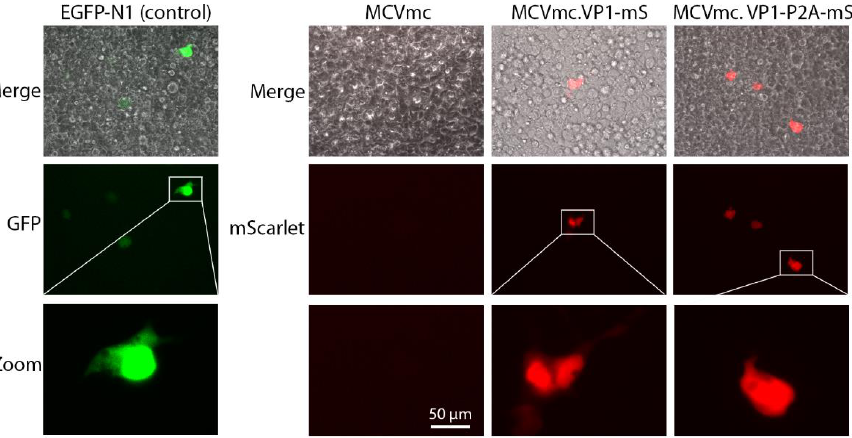
Figure 7. Single-round infection by pseudovirus-packaged MCV reporter. Images represent 293 MCVmc, MCVmc.VP1-mS (pseudo color red) or MCVmc.VP1-P2A-mS (red) reporter. Images